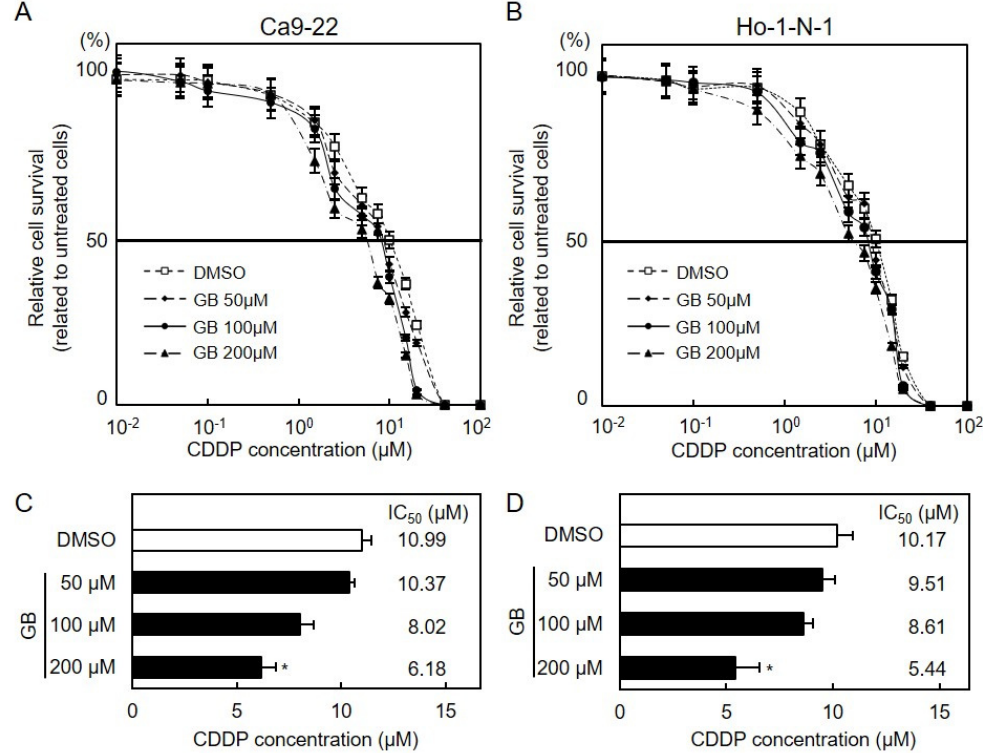
Figure 7. Effect of GB on CDDP sensitivity. ( A , B ) OSCC cells were seeded in 96-well plates at a density of 1 × 10 4 cells/well and treated with GB (0, 50, 100, and 200 µ M) for 24 h. Next, OSCC cells were treated with CDDP (0.01–1000 µ M) for 48 h, followed by a cellular viability assay. Values are expressed as the mean ± standard error of the mean in relation to untreated cells (Ca9-22 ( A ) and Ho-1-N-1 (B)). ( C , D ) IC 50 of CDDP in GB-treated cells (Ca9-22 ( C ) and Ho-1-N-1 ( D )). Asterisks indicate statistical significance compared with DMSO (Ca9-22 ( C ) and Ho-1-N-1 ( D ); Unpaired t -test; *, p < 0.05). CDDP, cisplatin; GB, ginkgolide B; OSCC, oral squamous cell carcinoma.